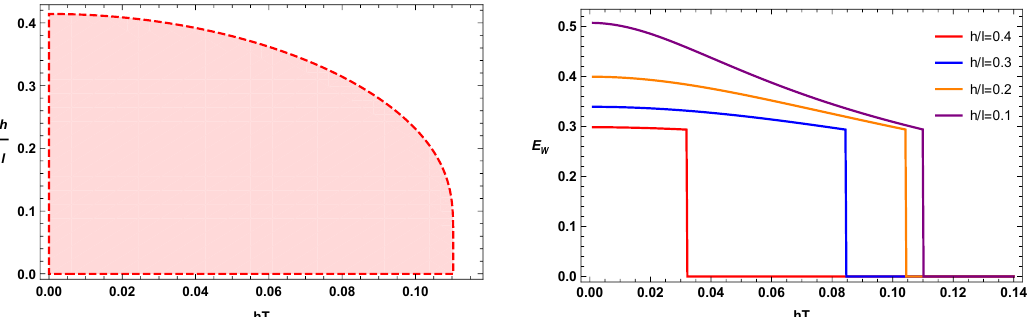
Figure 5 . Left : parameter space for d = 1 where E W is nonzero only in the red shaded region. Right : E W as a function of hT for di(cid:11)erent values of h=‘ . In all these cases E W undergoes a discontinuous phase transition beyond which it is identically zero. Here we set c =